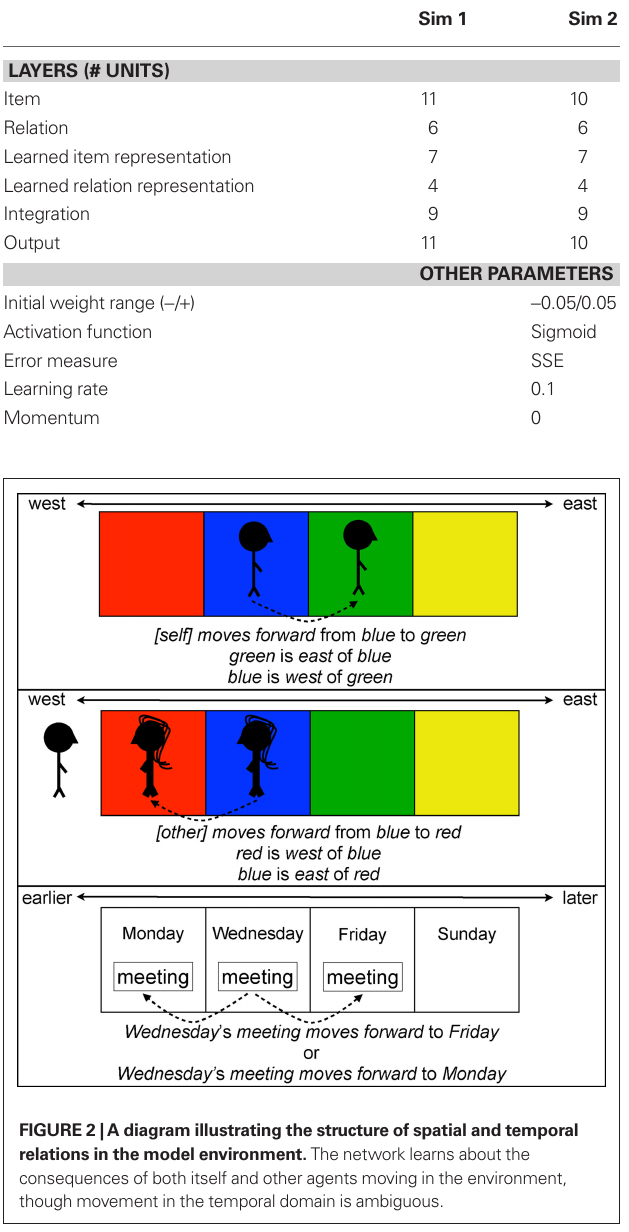
Table 1 | Detailed simulation parameters.